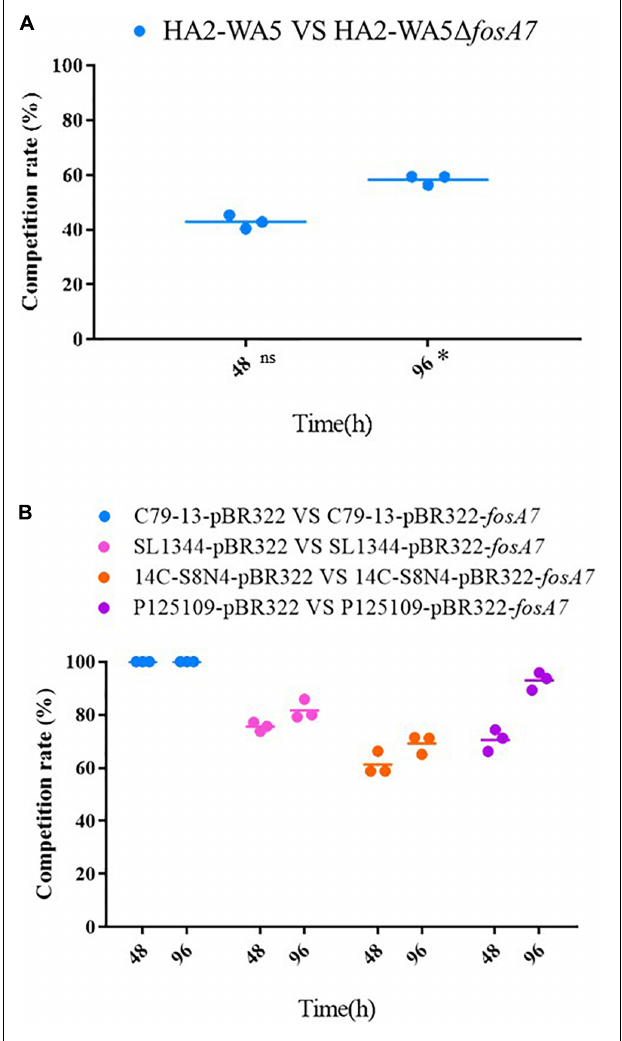
FIGURE 3 | Effects of fosA7 on bacterial relative fitness. (A) fosA7 -positive S . Derby HA2-WA5 and its fosA7 deletion mutant, ns indicates difference with no significance, ∗ indicates difference with significance; (B) plasmid-borne fosA7 in S . Pullorum C79-13, S . Typhimurium SL1344, S . Derby 14C-S8N4, and S . Enteritidis P125109. RF was calculated as percentage of transformants or deletion mutant in all